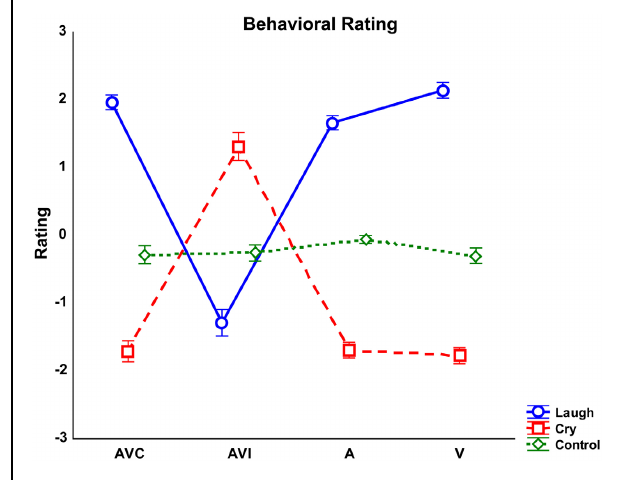
FIGURE 2 | Averaged rating scores detected for each modality (AVC, Audio-Visual Congruent; AVI, Audio-Visual Incongruent; A, Audio; V, Video) and emotion (Laugh, Cry, Control). Error bars represent standard errors of mean ( SE